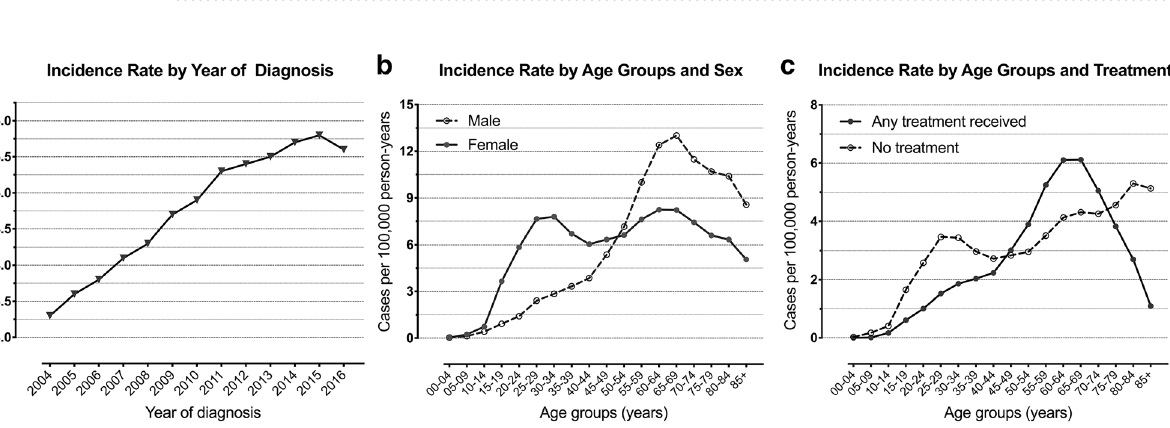
Table 3. Treatment strategies of patients with primary pituitary tumors. UPAs Uncertain behavior pituitary adenomas, PCs Pituitary carcinomas. Data presented as n (%) or just numbers. * P value for difference between UPAs and typical adenomas. ** P value for difference between UPAs + PCs and typical adenomas.